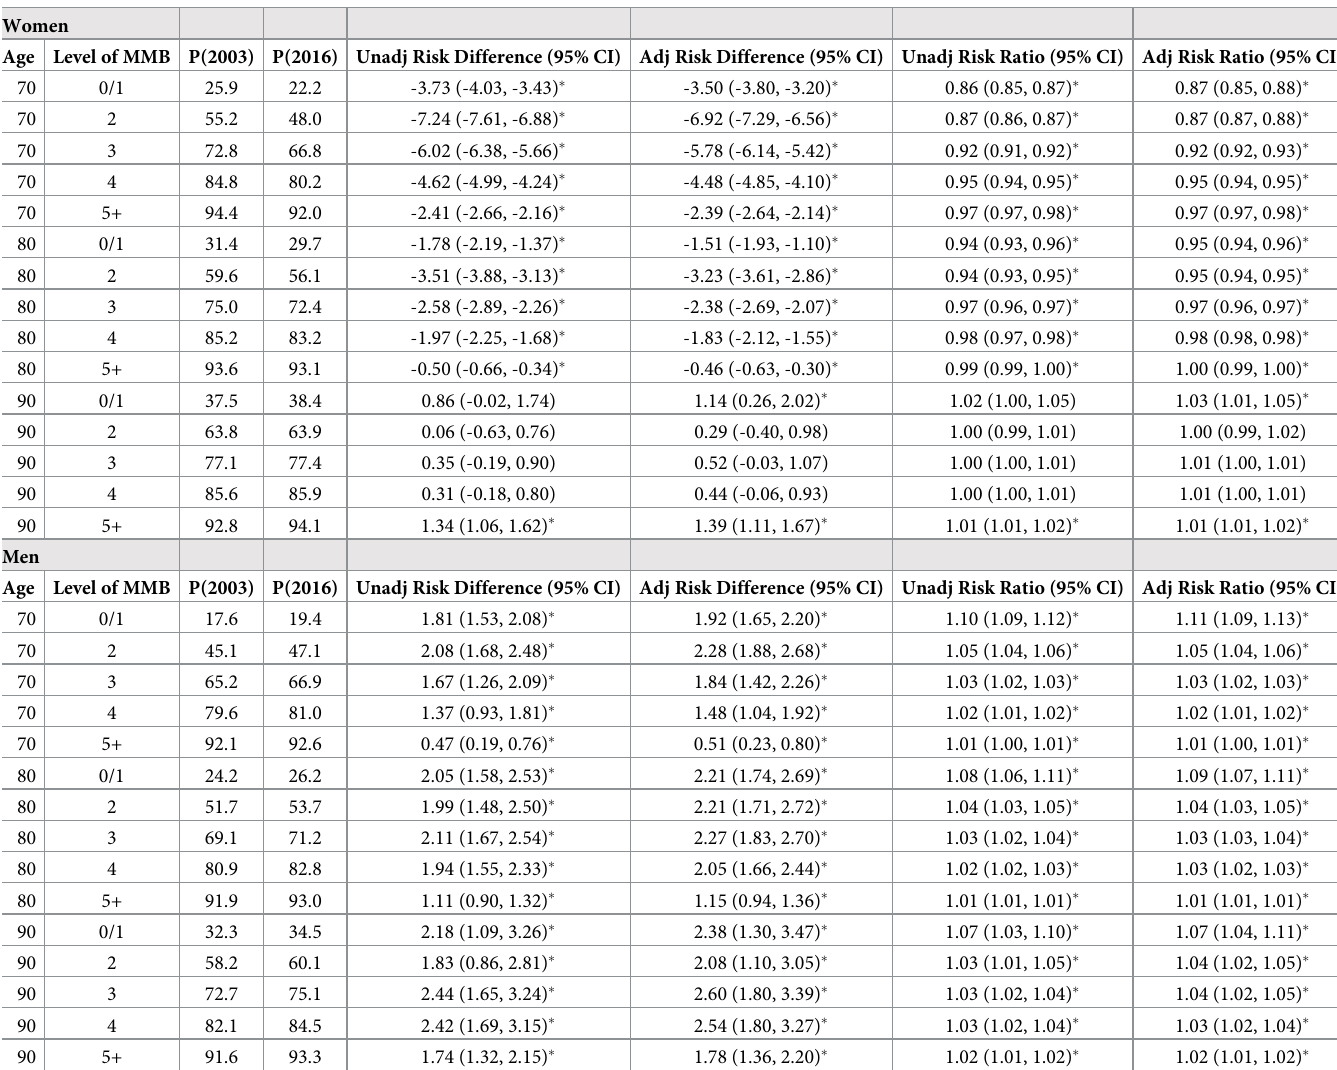
Table 2. Marginal probabilities of polypharmacy (5+ drugs) and unadjusted and adjusted risk differences and risk ratios (95% Confidence Intervals), by select ages, level of multimorbidity and sex.